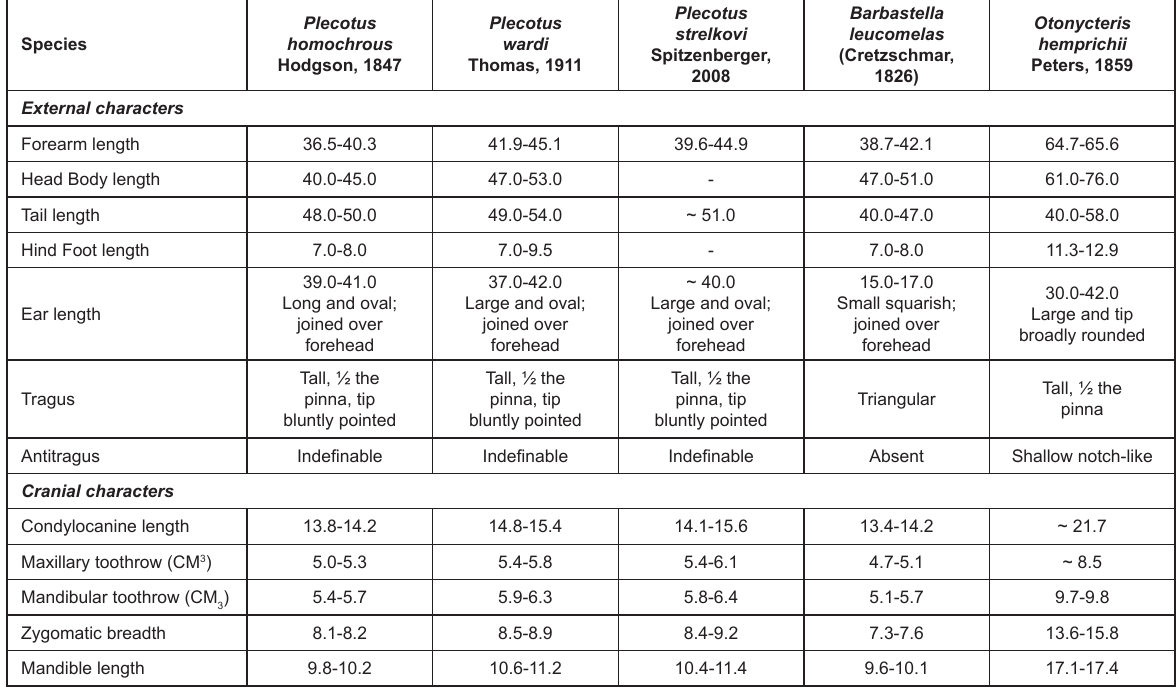
Table 7.4. Diagnostic morphological characters of the species belonging to the genera Plecotus , Barbastella and Otonycteris present in South asia